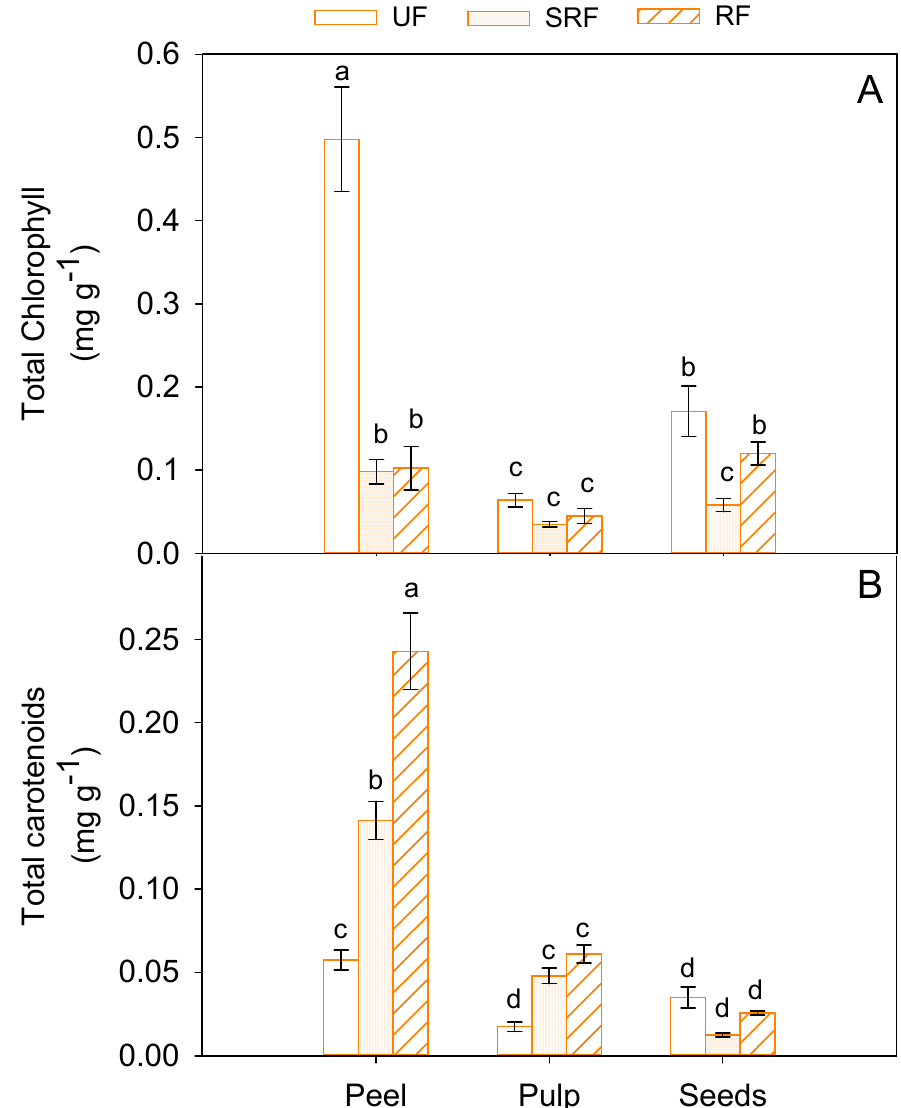
Figure 4. Total chlorophyll ( A ) and carotenoids ( B ) in peel, pulp, and seeds of unripe (UF), semi-ripe (SRF) and ripe fruits (RF), of Phlegrean mandarin. Each bar represents the mean ± SE ( n = 8). Different letters indicate significant differences ( p < 0.05), according to Duncan’s post-hoc test. GAE: gallic acid equivalents; CE: catechin equivalents; FW: fresh weight.